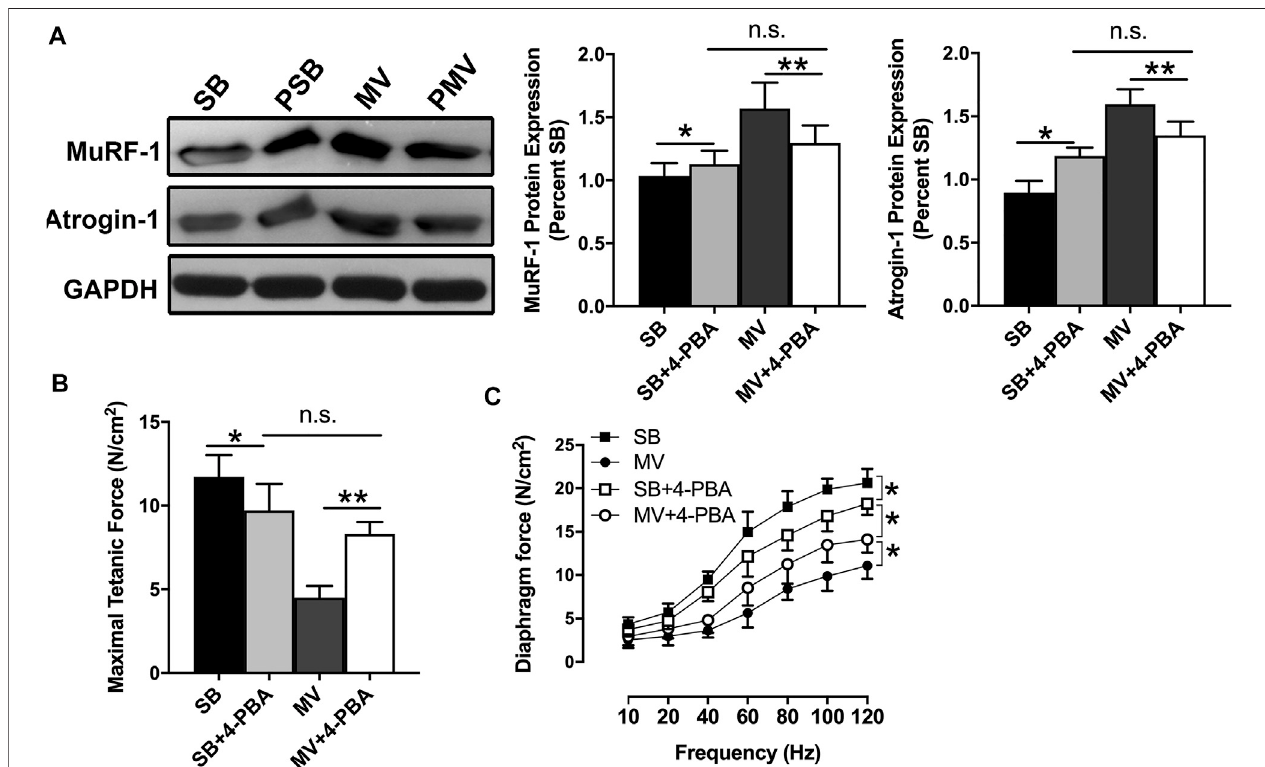
FIGURE4|I nhibitionofERstressinhibitsproteindegradationandimprovesdiaphragmcontractilecapacityduringMV. (A) ImmunoblotsforMuRF-1andAtrogin-1 expressions demonstrated reduced protein degradation in rats undergoing MV after 4-PBA treatment. In addition, diaphragm strips were studied ex vivo to evaluate force-generating capacity. The measurements of maximal tetanic forces (B) and force-frequency curves (C) showed that inhibition of ER stress by 4-PBA resulted in forcelossinSBratsandworseneddiaphragmweaknessinratsundergoingMV.* p < 0.05,** p < 0.01(ANOVAfollowedbytheTukeyHSDtest, n =6pergroup).MV = mechanical ventilation; SB = spontaneous breathing; 4-PBA = 4-phenylbutyrate.